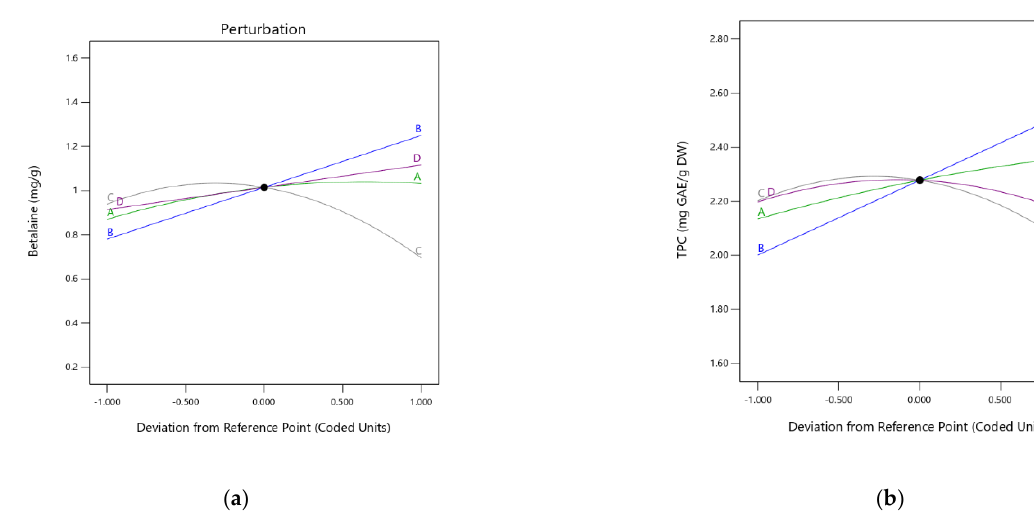
Figure 2. Graph of perturbations describing the effect of each independent variable (A, B, C, and D) on BT ( a ) and TPC ( b ) extraction.